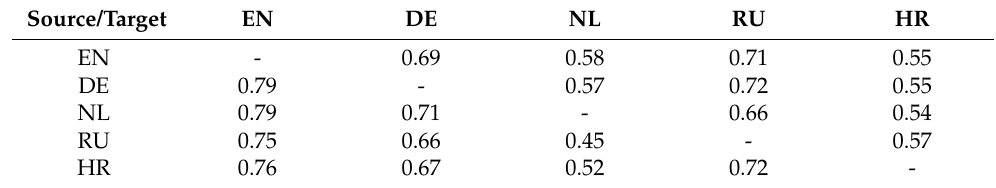
Table A6. Spearman’s correlation coefficients for distilled multilingual BERT model, 1000-word